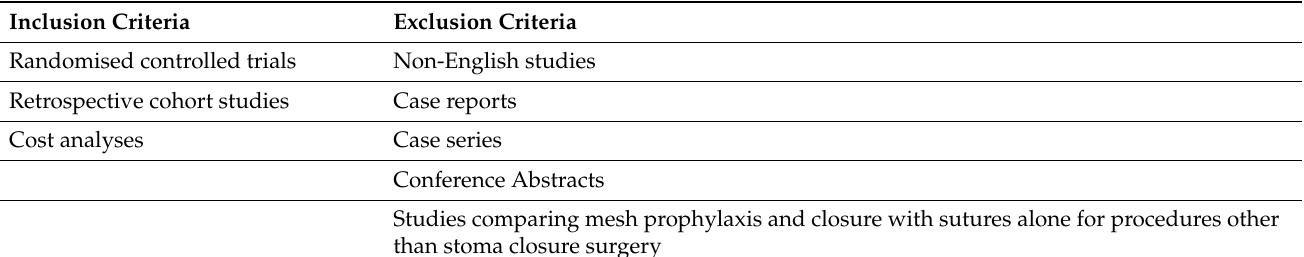
Table A1. Inclusion and exclusion criteria for the literature review.